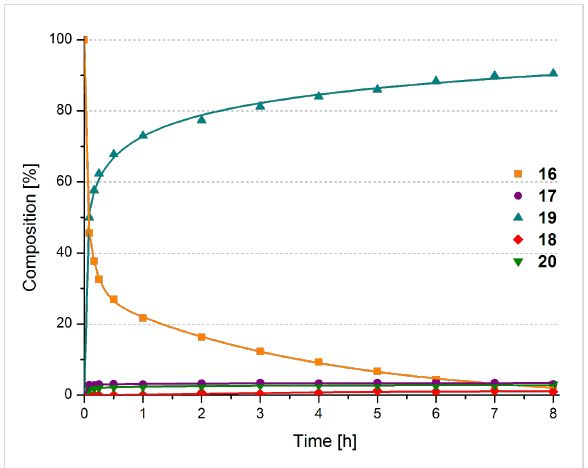
Figure 6: Composition of a reaction mixture after subjecting 16 to 5 mol % cis - 5a in xylene, 140 °C. Lines are intended as visual aids.